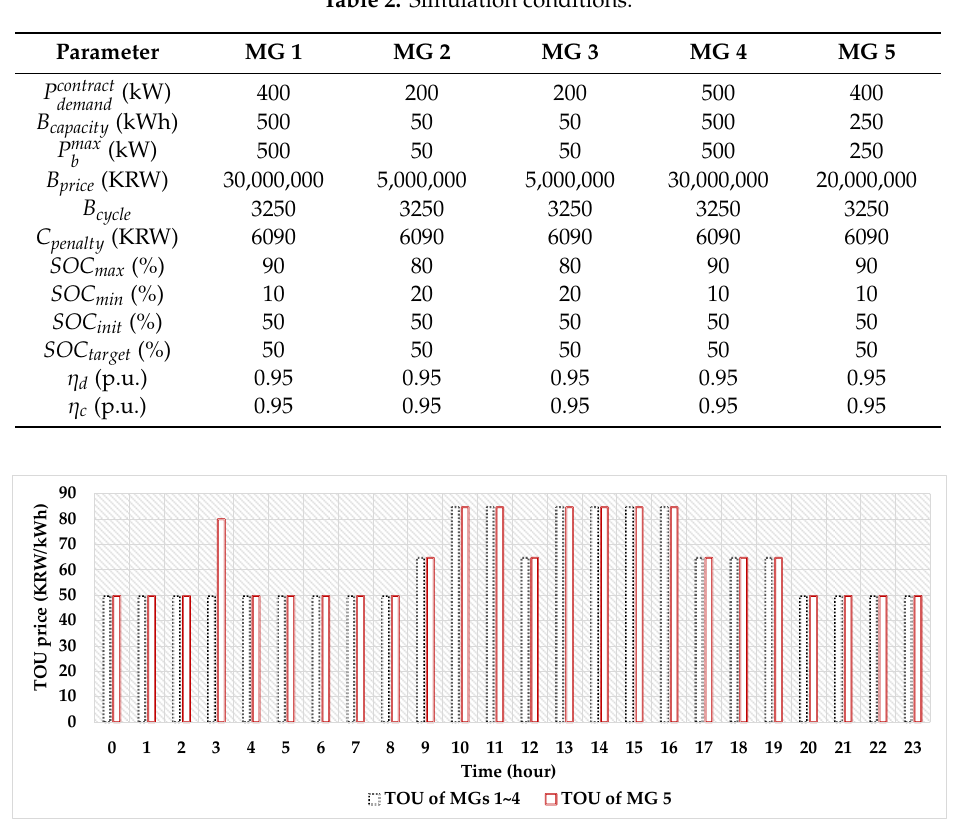
Figure 5. The time of use (TOU) prices of the MGs.